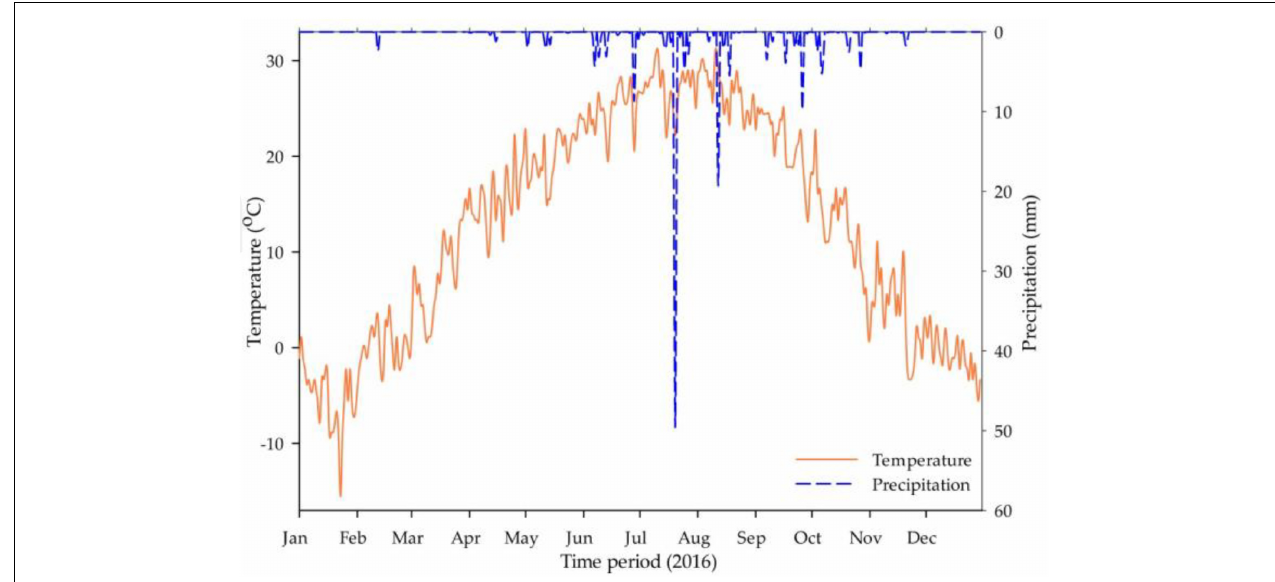
FIGURE 1 | The average daily temperature ( ◦ C) and rainfall event (mm) recorded in the Shunyi District in the year 2016 ( source: Weather Underground Online